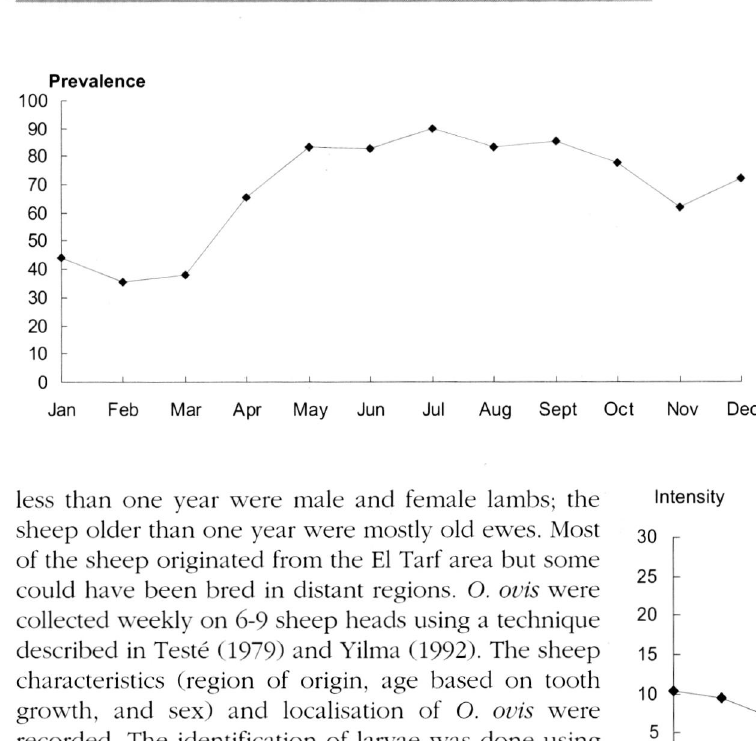
Fig. 2. - Seasonal evolution of intensity of Oestrus oris infection.